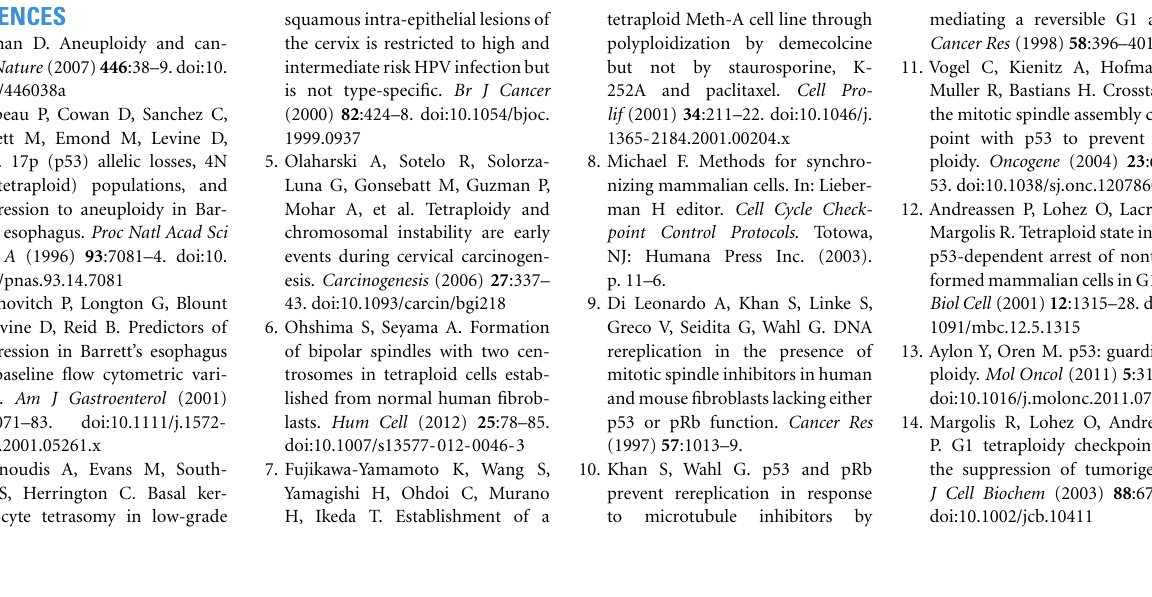
arrest observed after DC treatment in our study was caused